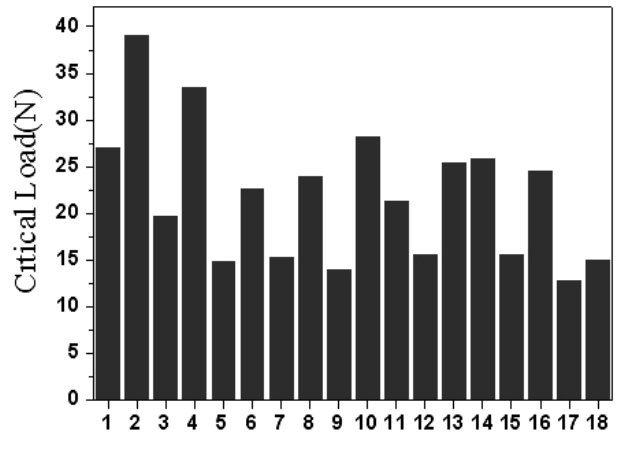
Figure 6. Critical load of No. 1~18 samples.